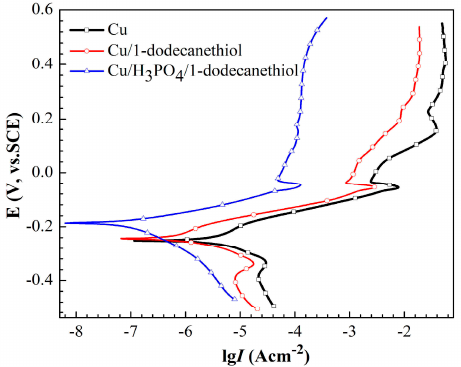
Figure 9. Potentiodynamic polarization curves obtained in 3.5% NaCl solution after 48 h for bare copper electrode, copper electrode with 1-dodecanethiol SAM, and copper electrode treated with H 3 PO 4 solution and modified with 1-dodecanethiol